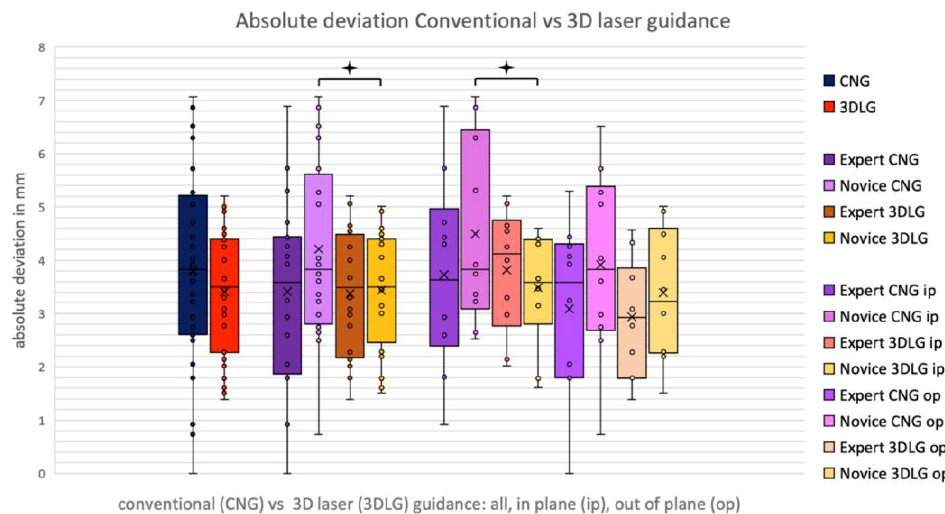
Figure 8. Absolute deviation for conventional needle guidance (CNG) and 3D laser guidance (3DLG), for expert and novice in in-plane and out-of-plane interventions.